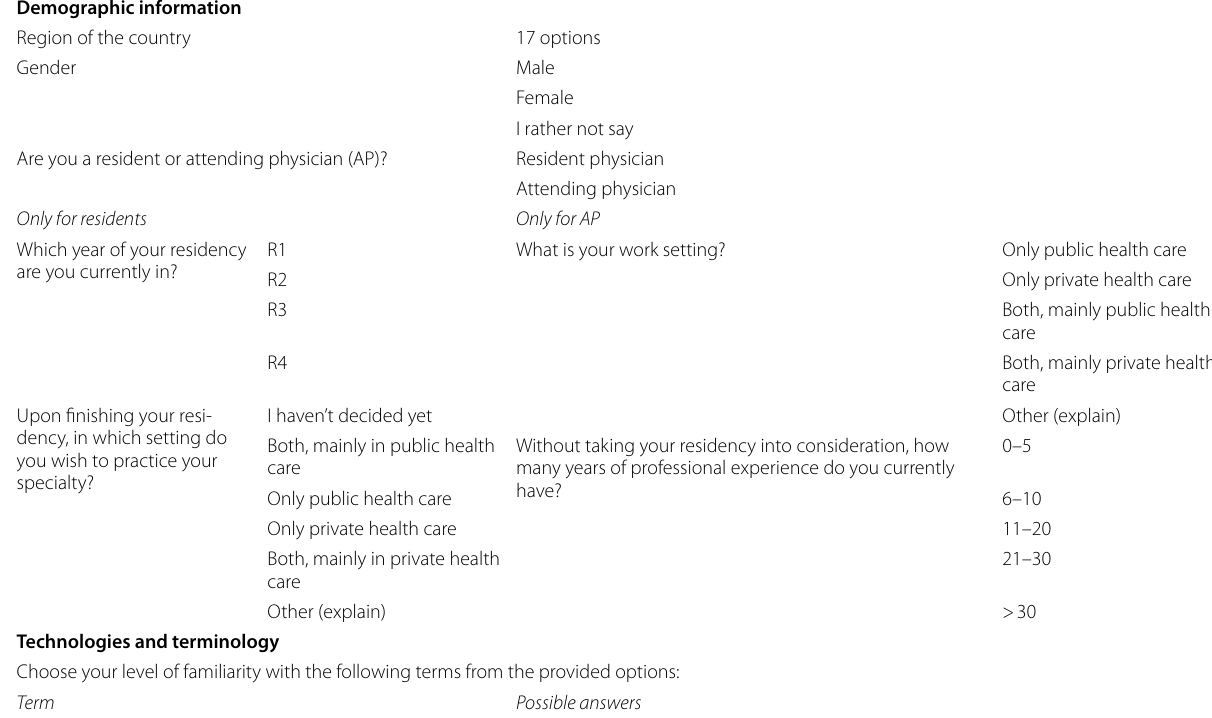
Table 1 Questions about the state of knowledge on imaging informatics and concerns, translated to English Demographic information Region of the